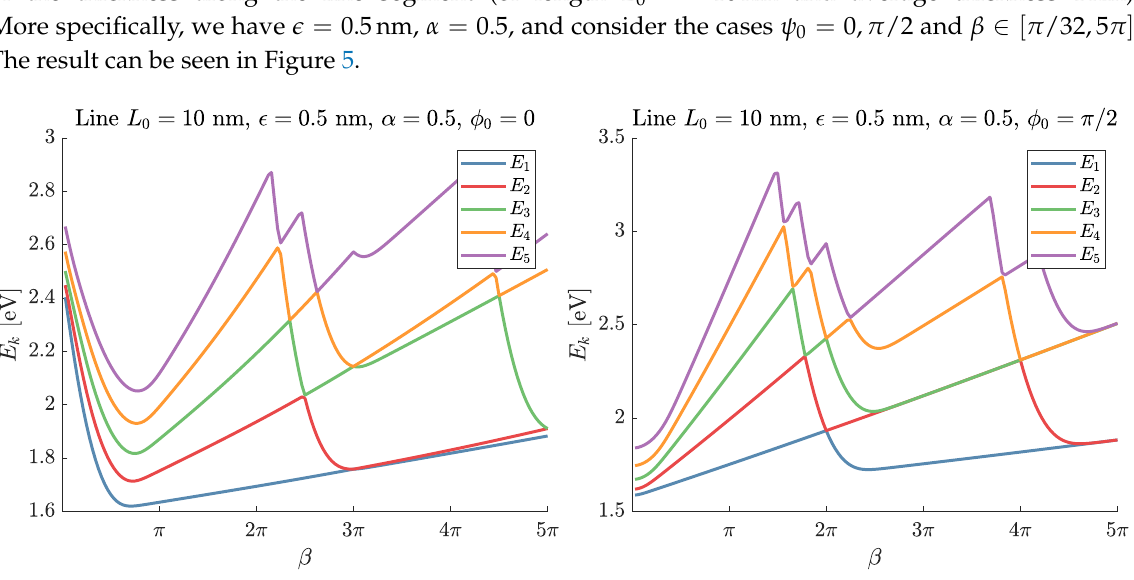
sin ( β s − ψ 0 ) and α = 2